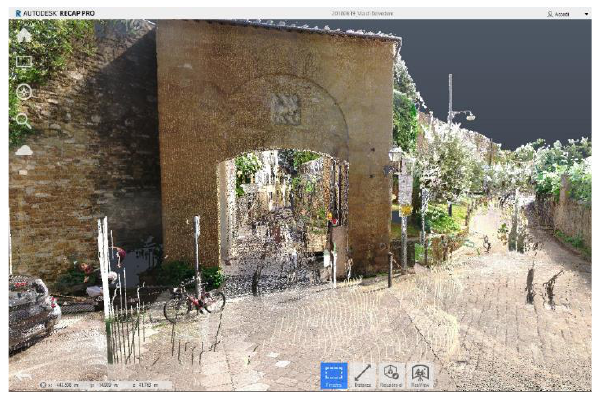
Figure 5. Detail of di Porta San